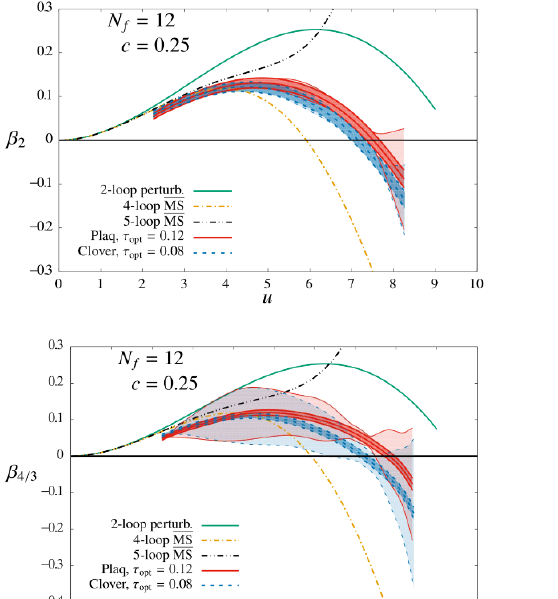
JHEP02(2018)132